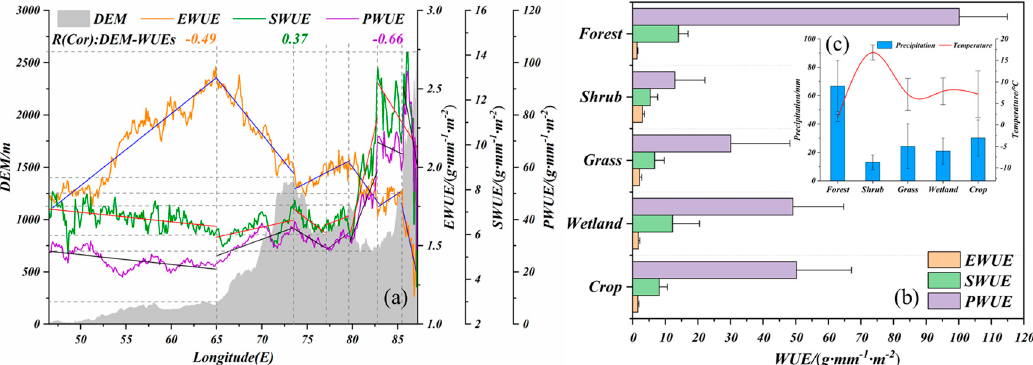
Figure 3. ( a ) Vertical gradients of EWUE, SWUE and PWUE, ( b ) comparison of EWUE, SWUE and PWUE values for different vegetation types, and ( c ) comparison of temperature and precipitation values for different vegetation types in Central Asia from 2000 to 2018.